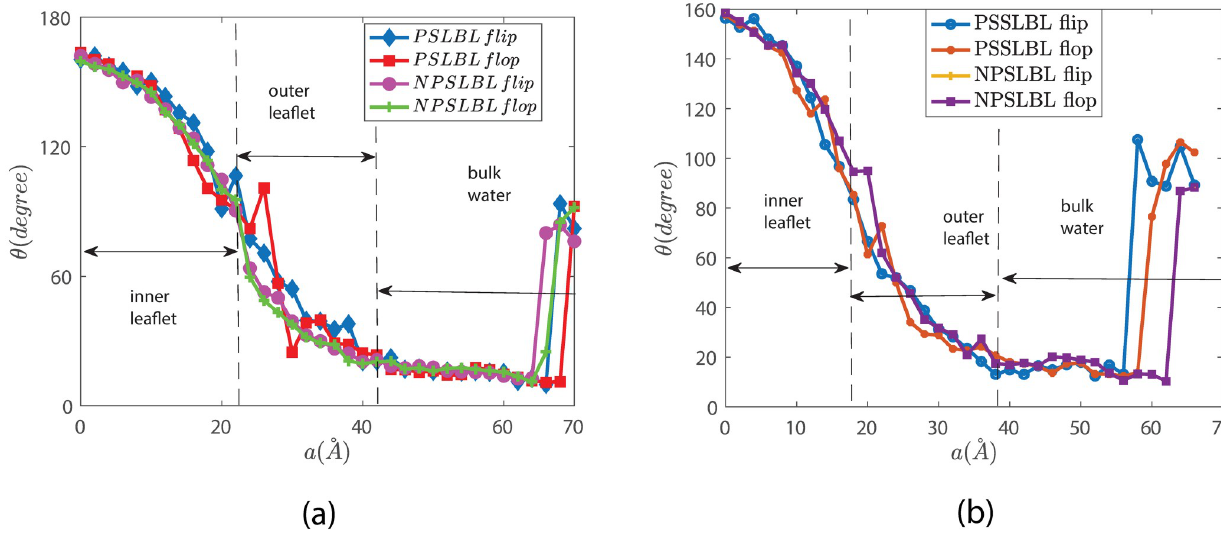
Fig 7. Variation of θ [see Figs 2(a) and 3(a) for definition] for the star lipid molecule as it traverses the LBL for both the PSSLBL and the NPSLBL. Results are shown for systems A (NPSLBL with NP composed of Nda beads) and C (PSSLBL with the planar support composed of Nda beads) in part (a) and for systems B (NPSLBL with NP composed of P5 beads) and D (PSSLBL with the planar support composed of P5 beads) in part (b). Also, in both (a) and (b), we identify the locations of the lipid bilayer and the bulk water. Furthermore, a = 0 Å represents the location of the inner leaflet for both the NPSLBL and the